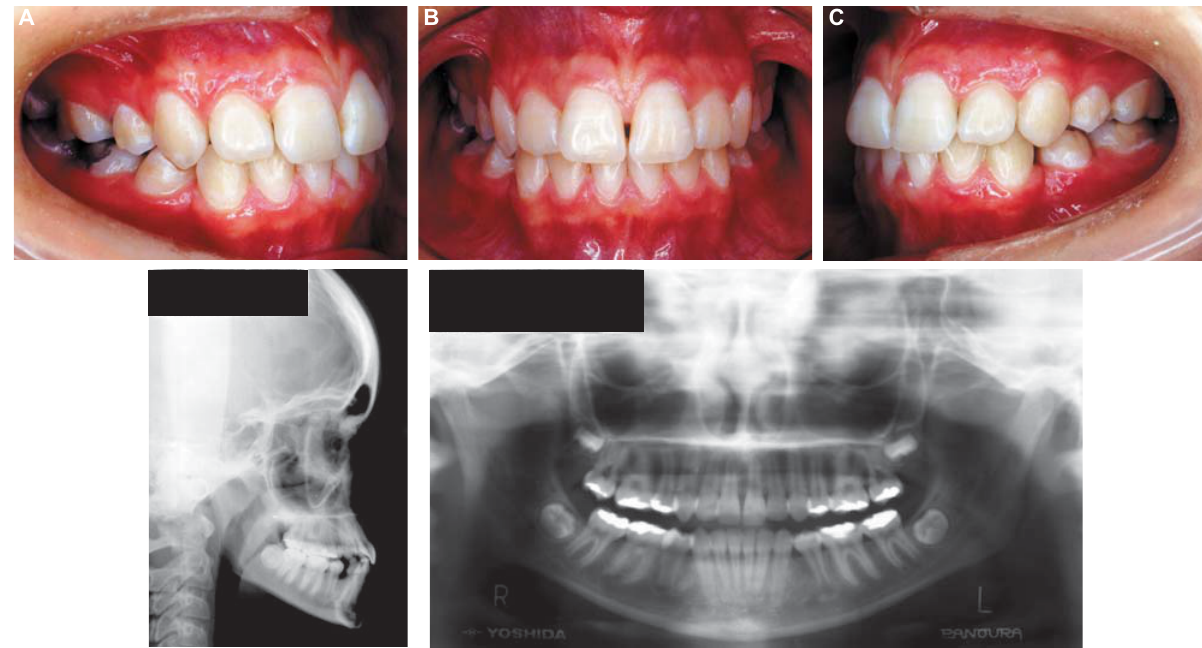
Figure 5- Intraoral photographs (A-C), lateral cephalogram (D), and panoramic radiograph (E) at the end of the interceptive stage A